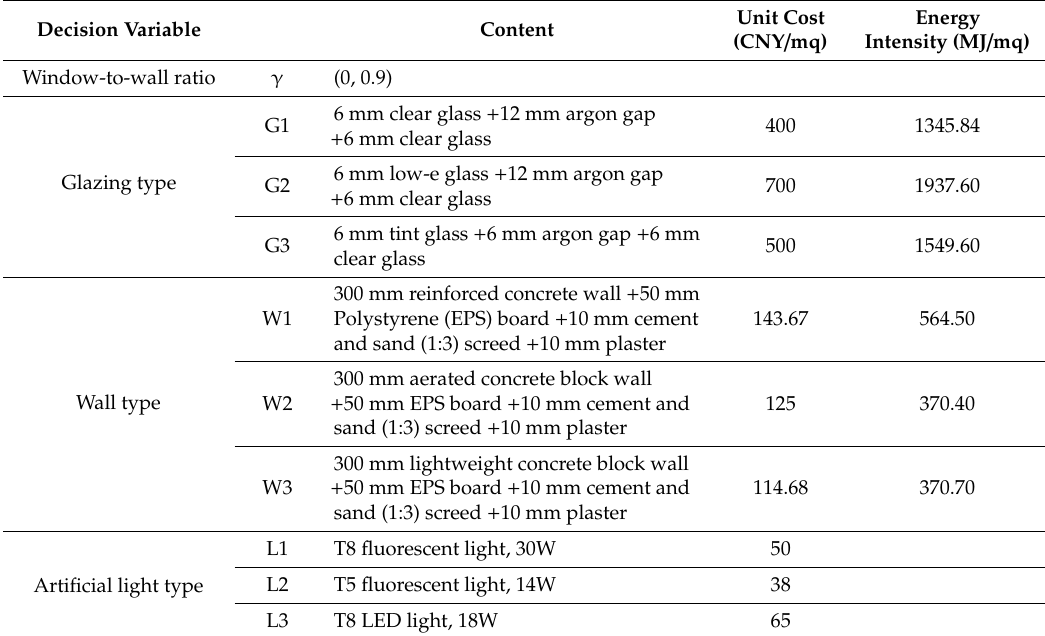
Table 2. Information of decision